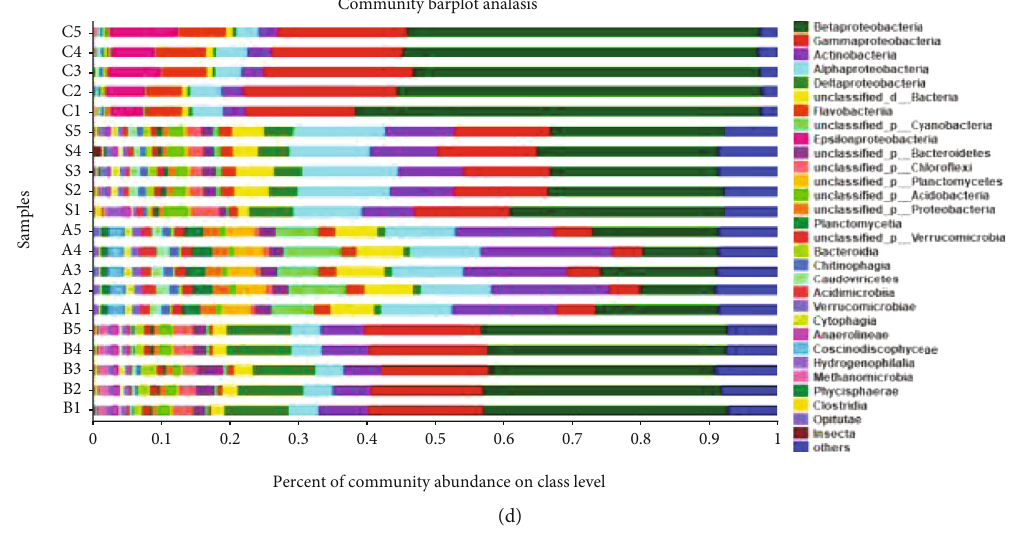
Figure 1: Bacterial population composition in samples of wastewater. (a) Levels of phyla. (b) Levels of genera. (c) Levels of species. (d) Levels of